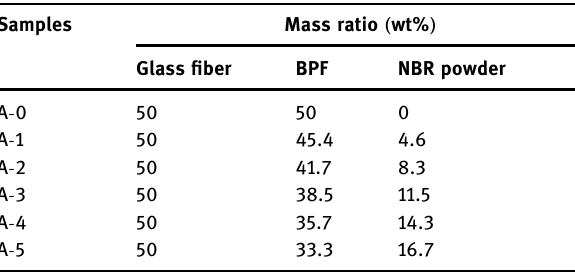
Table 2: The formulation of NBR/BPF composites Samples